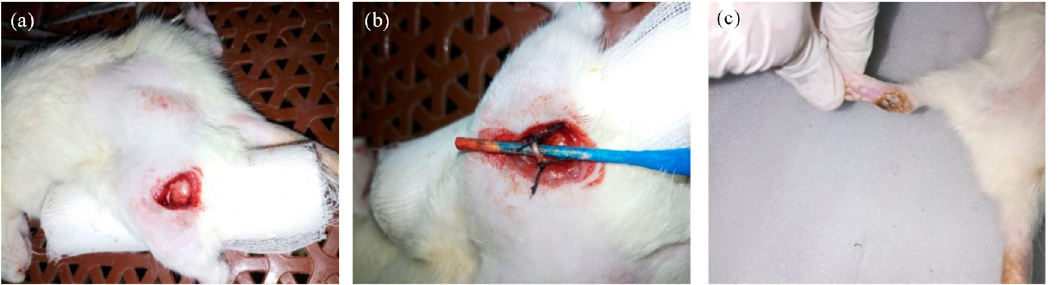
Figure 1. ( a ) Exposing Sciatic nerve, ( b ) Constriction of Sciatic nerve, and ( c ) Scarring of the skin at heel.